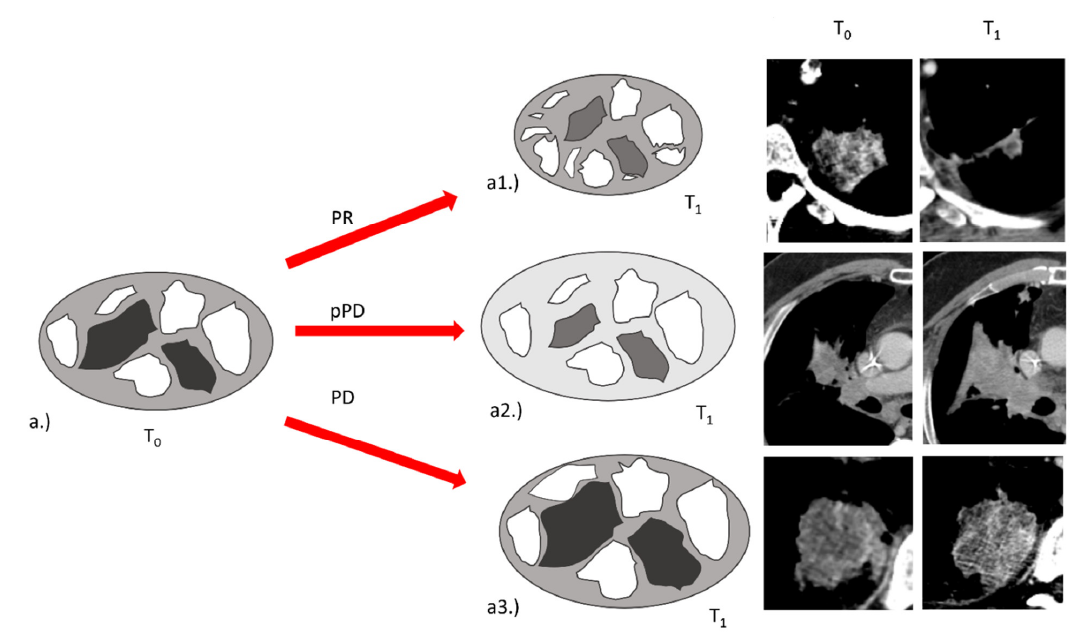
Figure 5. Exemplification of the variations of LAHGLE and LALGLE after the introduction of immunotherapy. ( a ) At baseline a tumor presented with different zones of enhancement (white) and low attenuation (dark grey) within the tumor (light grey). ( a1 ) In PR, the tumor shrinks and the values of LAHGLE and LALGLE decrease, indicating a reduction in dimension of high and low attenuation “large zones”. ( a2 ) In pPD, the tumor enlarges and the values of LAHGLE increase but LGLZE decrease, indicating a reduction of low attenuation zones on a global level (the background and the low attenuation zones become lighter) and enlargement of high attenuation zones. In pPD LALGLE is not different from PD, but the difference in LGLZE is consistent, meaning that large areas are not exclusively affected, but the process that involves the reduction of low attenuation pixels occurs on a global instead of a local level. ( a3 ) In PD, the tumor enlarges and the values of LAHGLE and LALGLE increase, indicating a growth of high and low attenuation “large